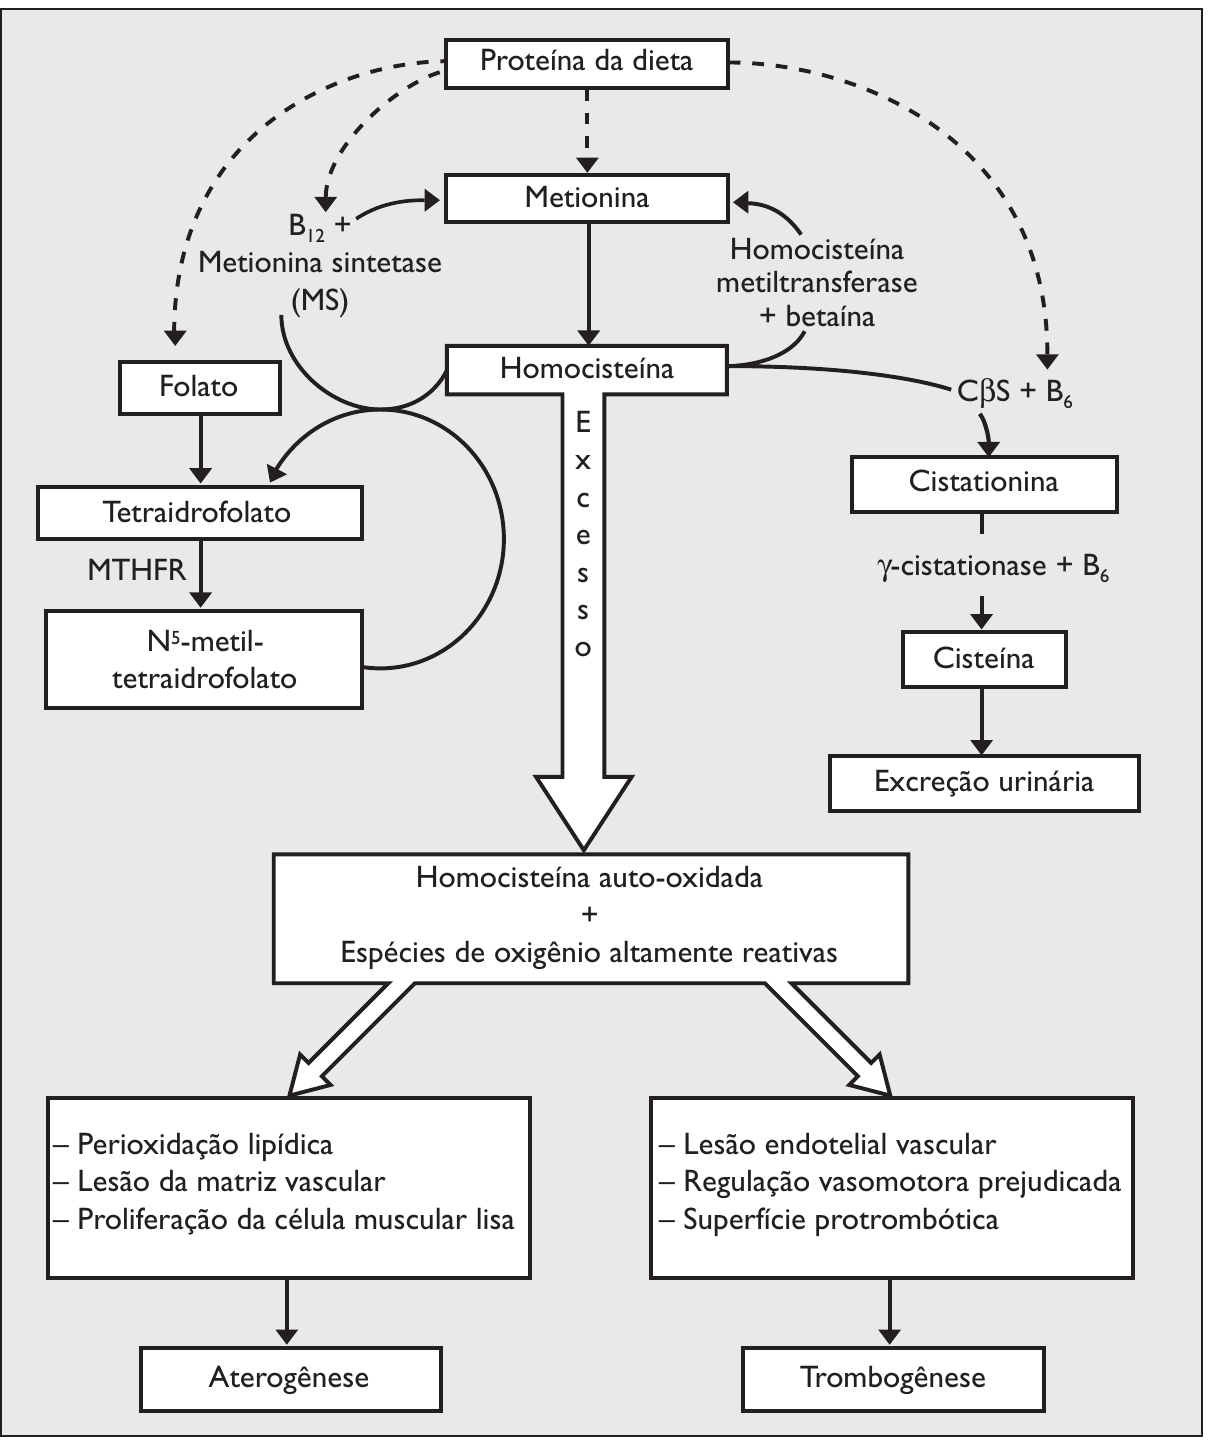
Figura 1 – Metabolismo da homocisteína e possível mecanismo de doença aterotrombótica (32) . MTHFR = metileno-tetraidrofolato redutase; C β S = cistationina β